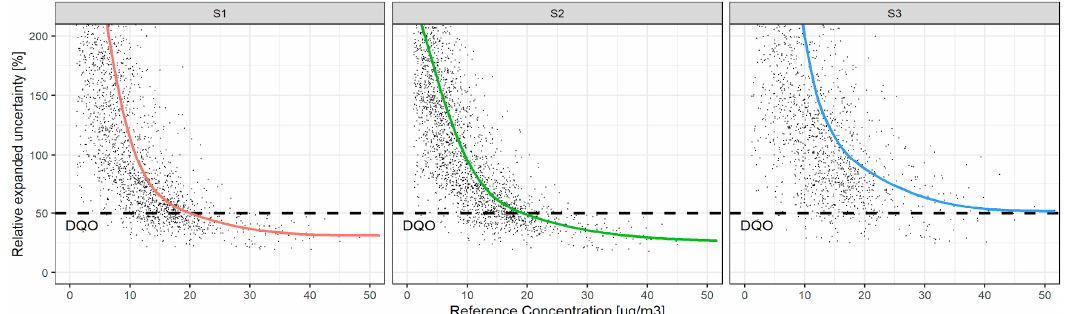
Figure 13. Relative expanded uncertainty of the three sensor units as a function of PM 2.5 concentration at the station. The dots indicate the actual hourly average data points, whereas the coloured lines represent the fit of a generalized additive model (GAM) to the data. The dashed black line indicates the data quality objective (DQO) for indicative measurements as described in the European Air Quality Directive [10].